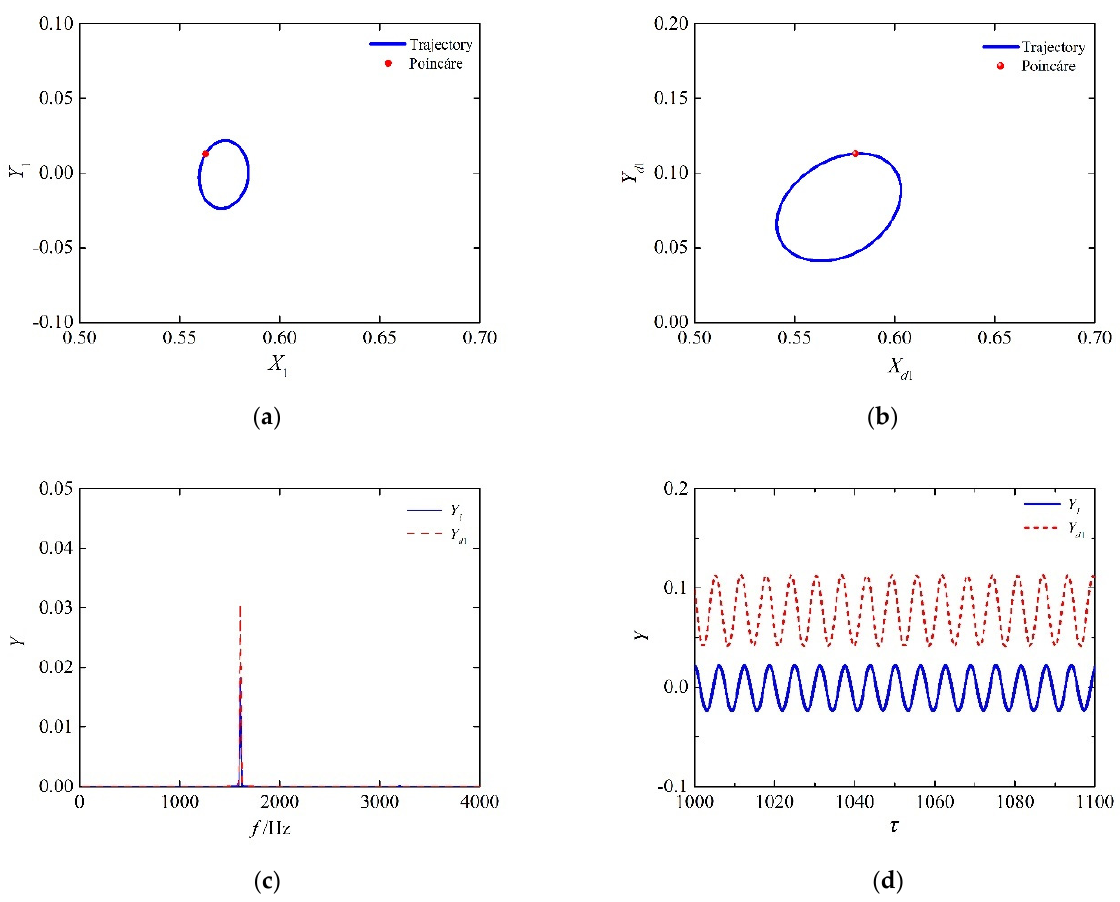
Figure 7. Periodic motion of the rod–fastened rotor at ω = 1500 rad/s: ( a ) orbit and Poincaré map at the left bearing station; ( b ) orbit and Poincaré map at the left disk station; ( c ) comparison of spectrogram at the left disk and left bearing stations; ( d ) comparison of the time series diagram at the left disk and left bearing stations.